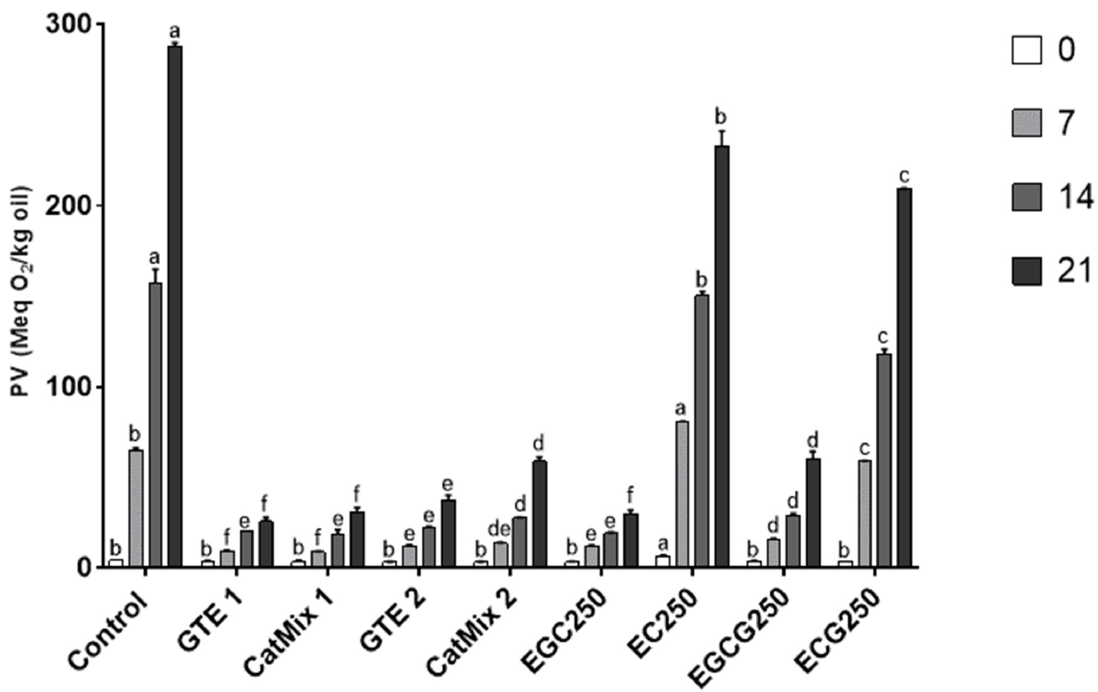
Figure 3. Effect of green tea extracts (GTEs) and catechins on the peroxide value (PV) of DHA-rich oil during a 21-day storage at 30 °C. Results are expressed as mean ± standard deviation, n = 3. Control = DHA-rich oil, GTE1 = DHA-rich oil + 1000 ppm GTE1, CatMix1 = DHA-rich oil + reconstituted catechin mixture of GTE1, GTE2 = DHA-rich oil + 450 ppm GTE2, CatMix2 = DHA-rich oil + reconstituted catechin mixture of GTE2, EGC250, EC250, EGCG250 and ECG250 = DHA-rich oil + 250 ppm of EGC or EC or EGCG or ECG, respectively. Significant differences ( p ≤ 0.05) are represented by different lower-case letters (a–f) among treatments at a specific storage time.